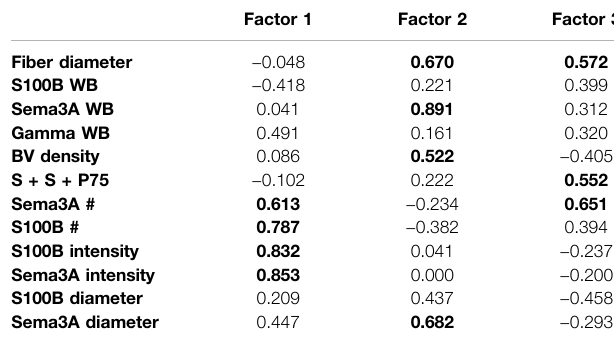
TABLE 4 | Loading correlations of variables onto 3 factors identi fi ed by principal component analysis of the dataset from muscles regenerating after pretreatment with ISDN before muscle-crush or cardiotoxin injury. WB indicates protein assays by Western blotting, BV = blood vessel; # indicates the number of expression sites (by in situ hybridization, ISH); “ S + S + P75 ” indicates the number of regions in which P75 protein (by immunostaining) was colocalized with S100B and Sema3A transcripts (by ISH); intensity and diameter refer to measurementsof fl uorescentregionsofS100BorSema3AmRNAexpression (by ISH). Loading coef fi cients greater than 0.5 (in bold type) were considered strong